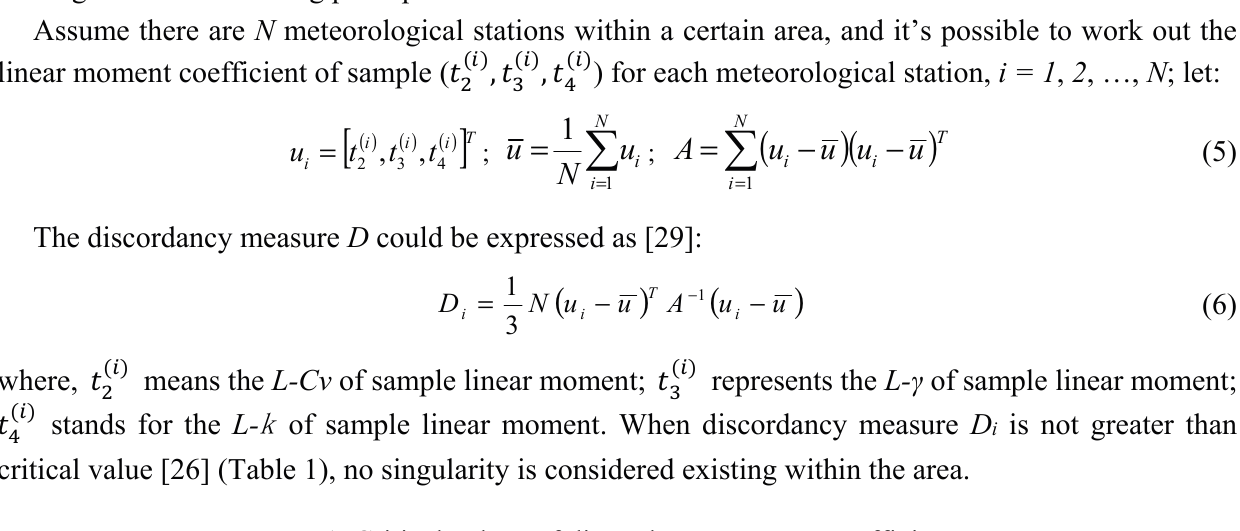
Table 1. Critical values of discordancy measure coefficient D